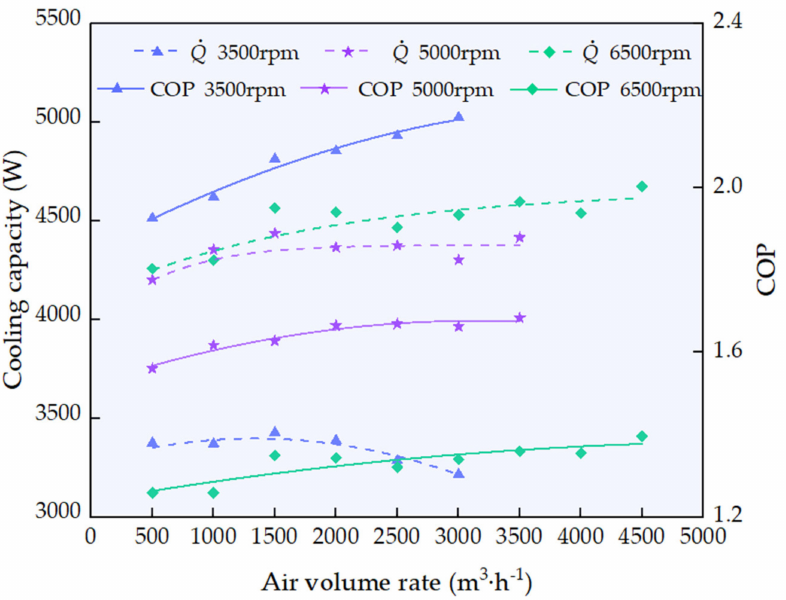
Figure 9. Influence of compressor speed on the optimal gas cooler air volume flow